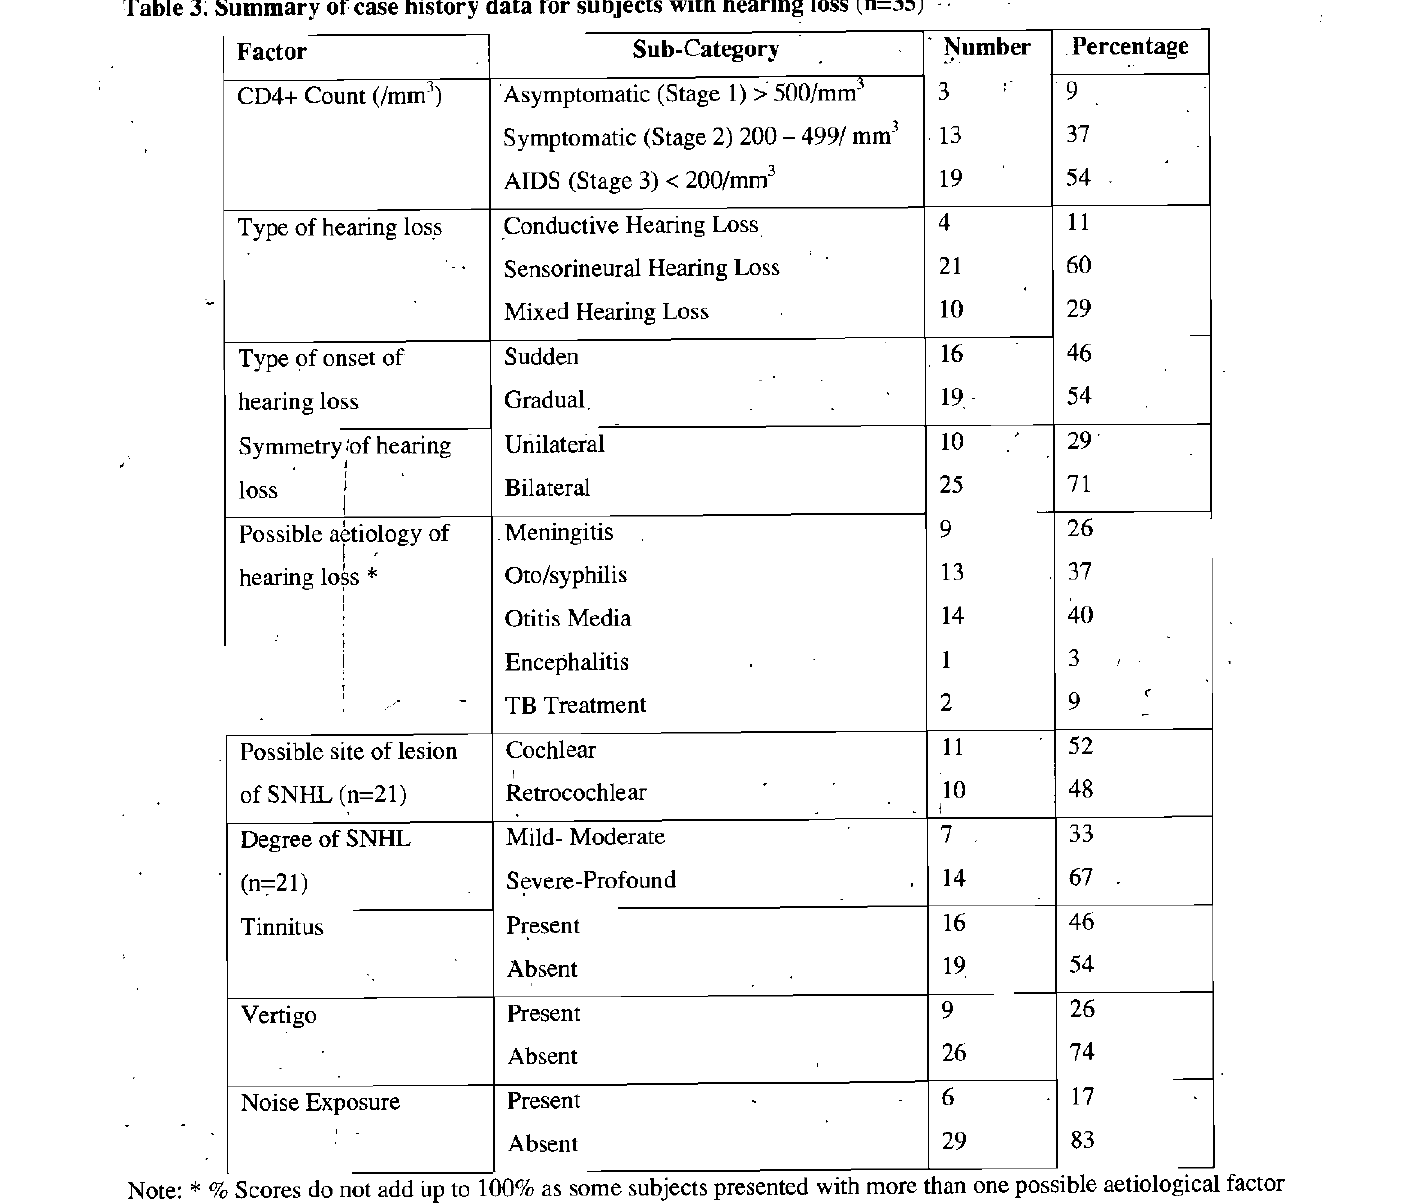
Table 3: Summary of case history data for subjects with hearing loss